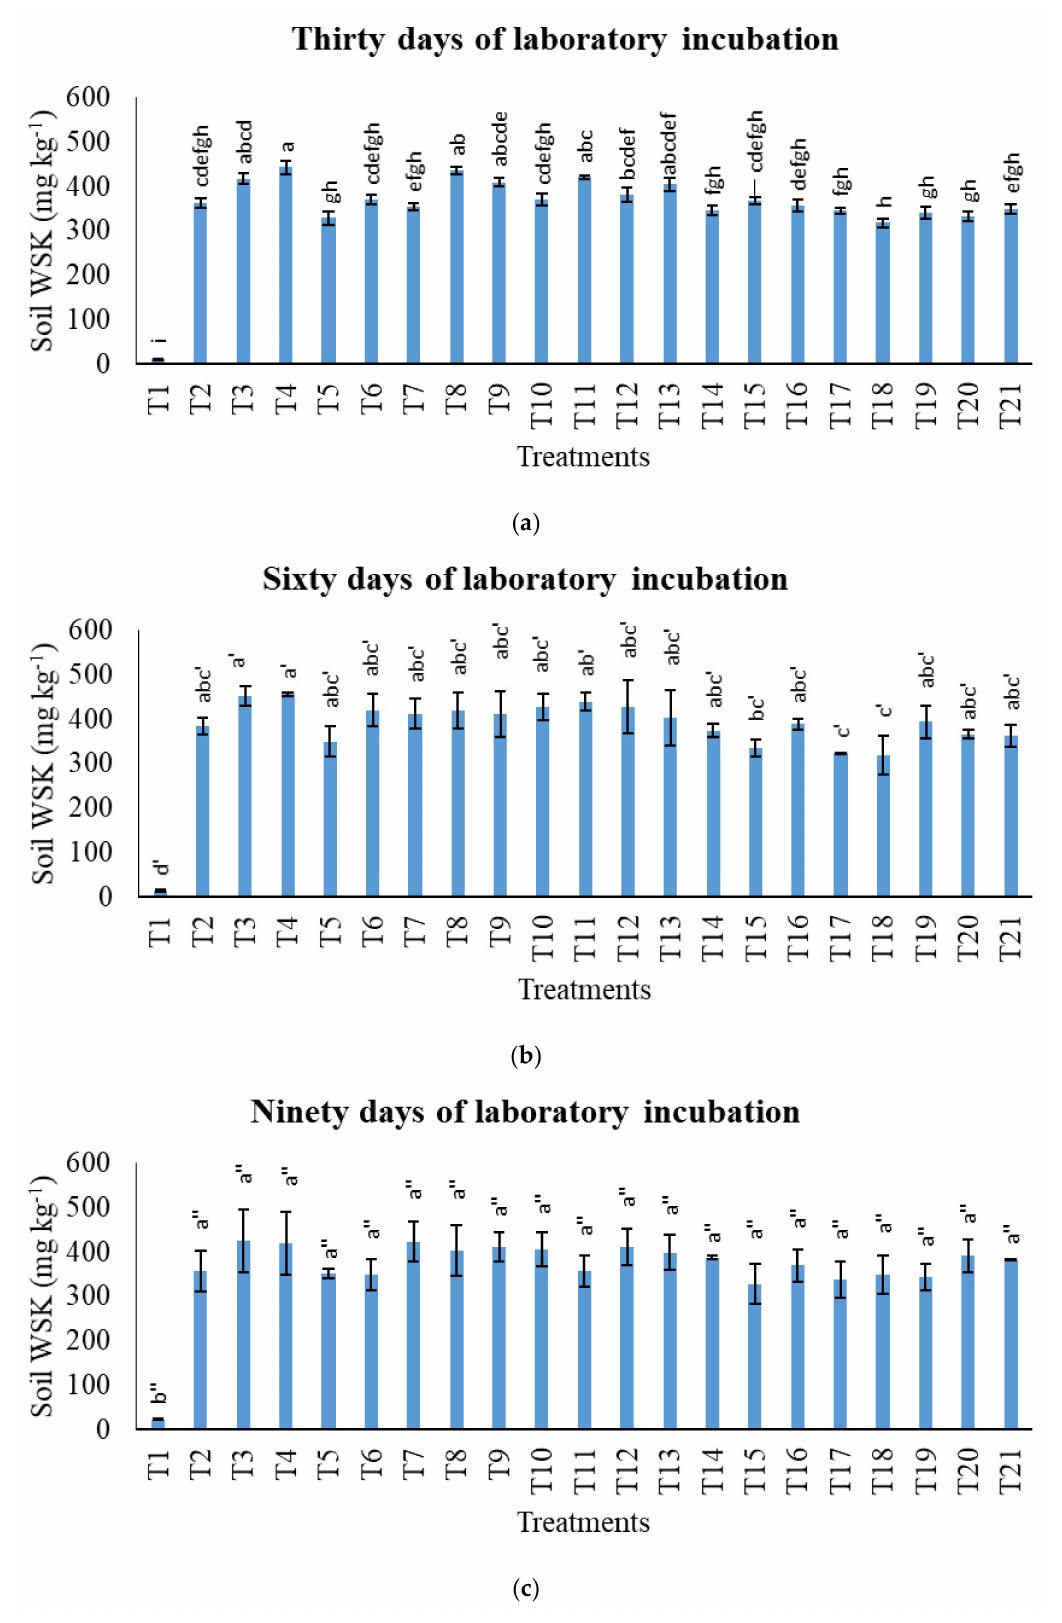
Figure 12. Effects of treatments on soil water-soluble potassium over ( a ) thirty; ( b ) sixty; and ( c ) ninety days after incubation. T1: soil control, T2: conventional practice, T3: muriate of potash + 100% charcoal + 100% sago bark ash, T4: muriate of potash + 100% sago bark ash, T5: muriate of potash + 100% charcoal, T6: muriate of potash + 80% charcoal + 80% sago